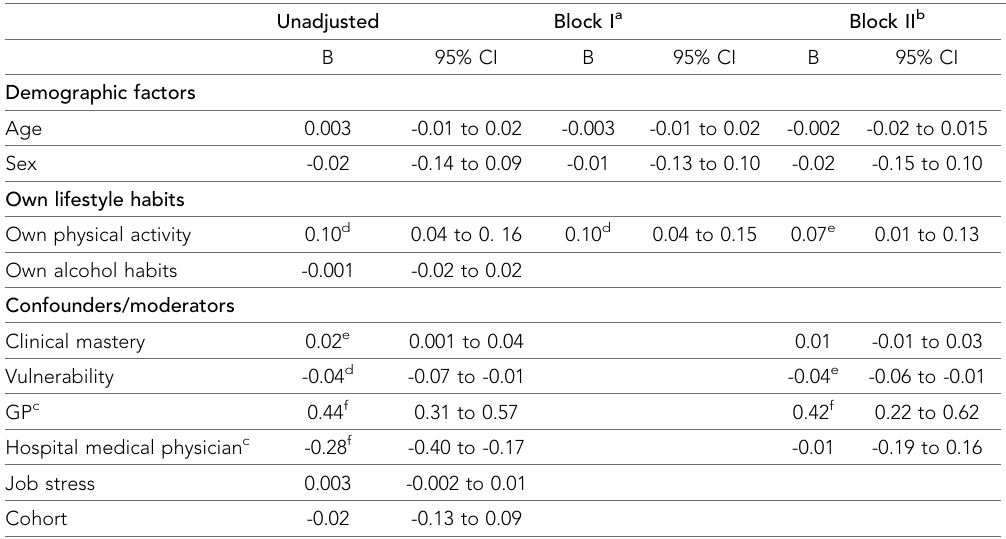
Table 1. Factors associated with counselling about physical activity in 2014